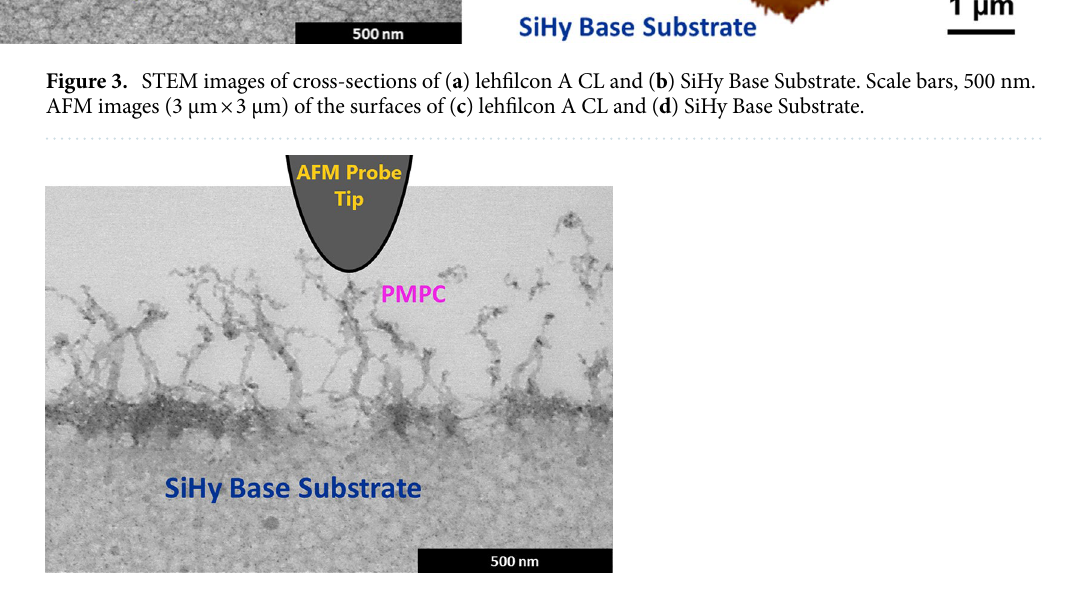
Figure 4. Schematic showing the STEM image of a lehfilcon A CL and the indenting AFM probe tip (drawn to